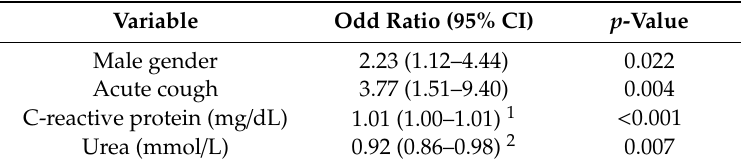
Table 2. Association of predictor variables with the presence of pneumonia.